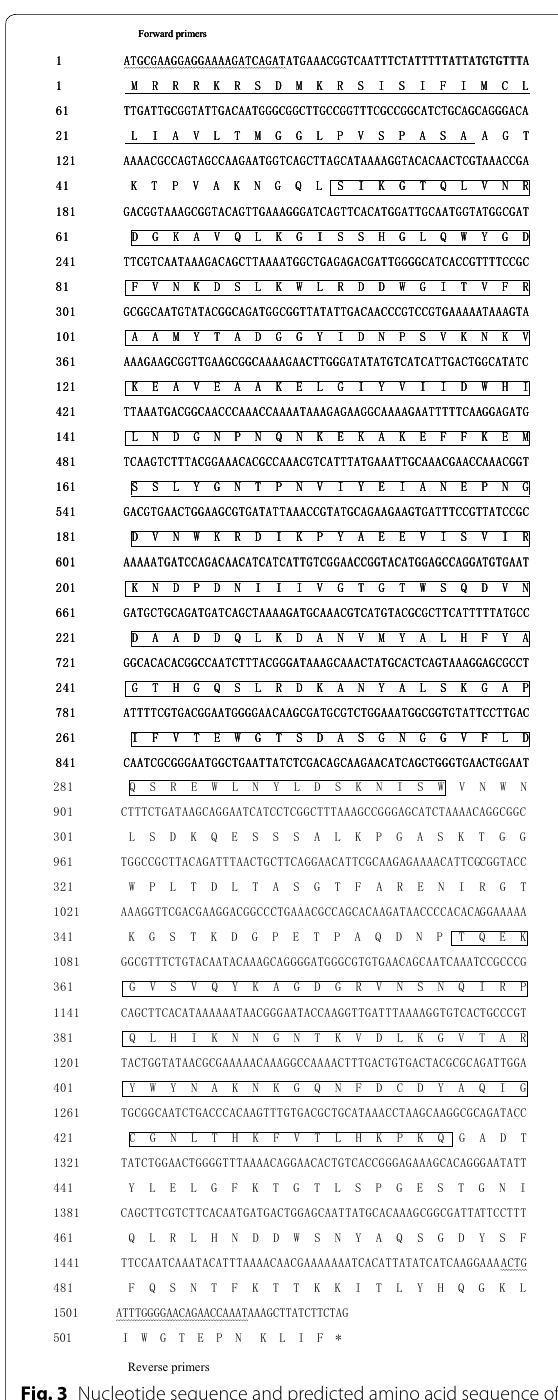
Fig. 3 Nucleotide sequence and predicted amino acid sequence of Egls from B. velezensis A4. The underlined amino acid (1–37 amino acids) shows the putative signal peptide. The wave lines indicate the primers. The regions of amino acids (50–296) and (356–437) pre- dicted as cellulose domain (glycosyl hydrolase family 5) and CBM_3 cellulose-binding domain, respectively, are depicted in boxes. Asterisk indicates the stop